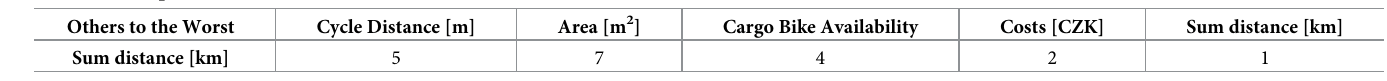
Table 10. Comparison of other alternatives to the worst one.